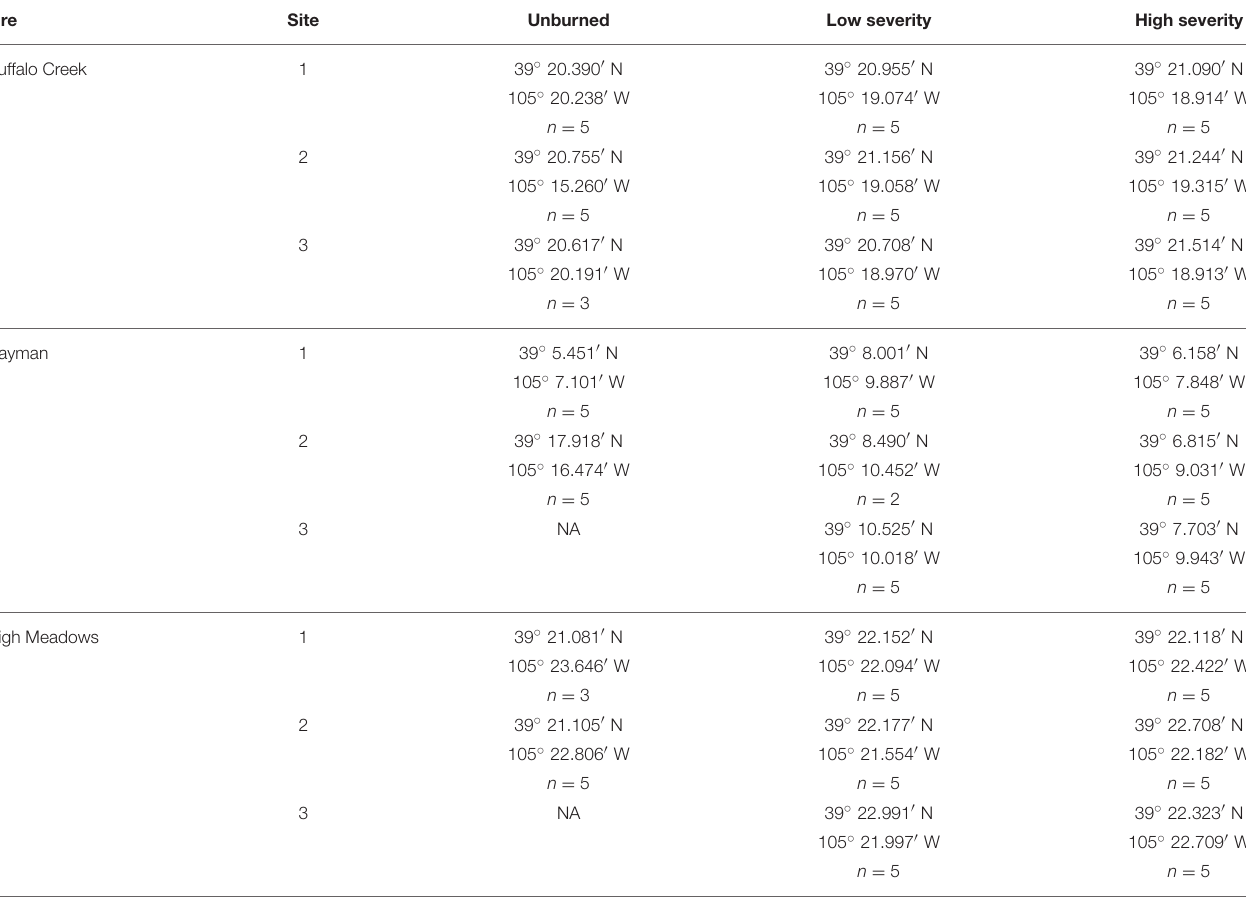
TABLE 1 | GPS coordinates for each of the sampling locations and number of wax currant plants sampled at each site. Fire